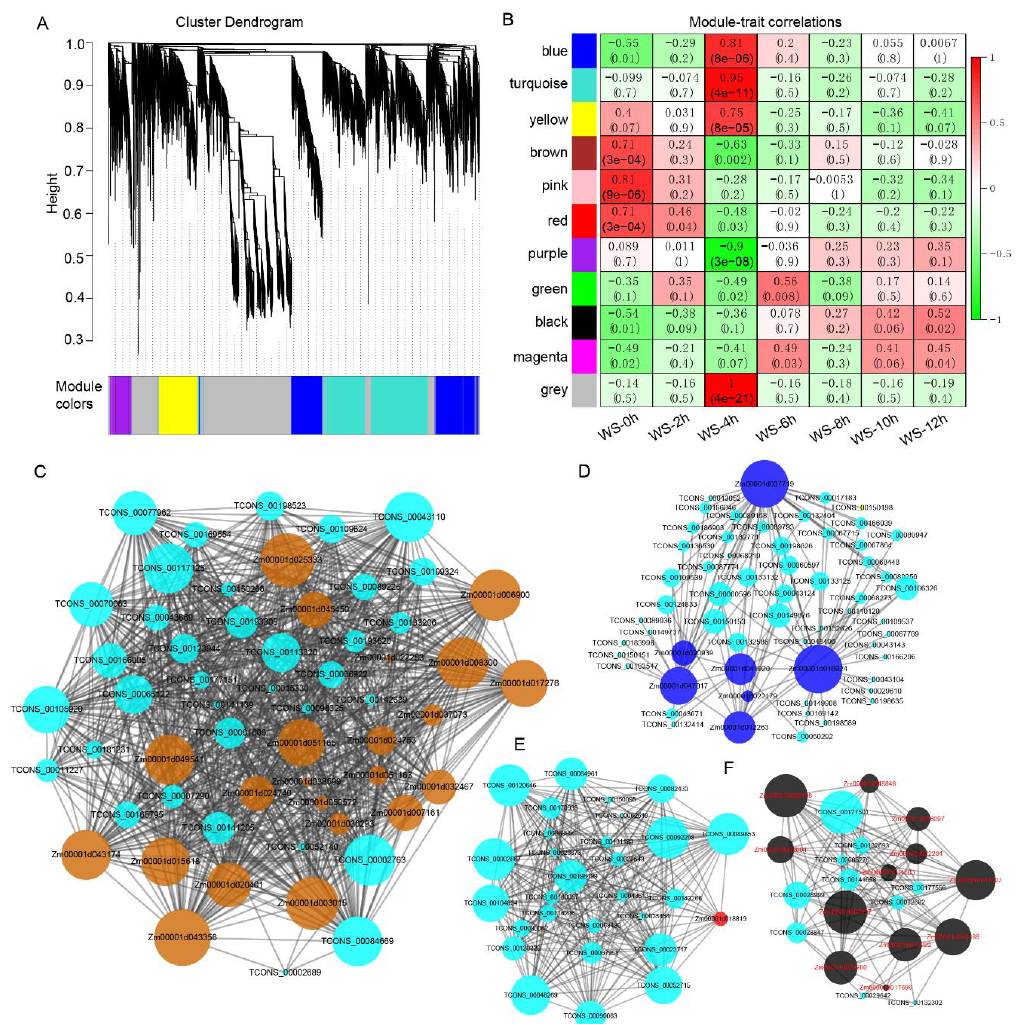
Figure 4. Co-expression network of the transcripts, including the protein-coding genes (PCgenes) and long non-coding RNA (lncRNAs) involved in waterlogging stress in maize root tips. ( A ) Hierarchical cluster tree and color bands indicating the 11 modules identified by the weighted gene co-expression network (WGCNA). ( B ) Analysis of the module – trait association. Each row represents a module, and each column represents a sample under waterlogging stress (WS) conditions. The numbers on the top and bottom of each cell represent the correlation and significant p-values, respectively. ( C ) The